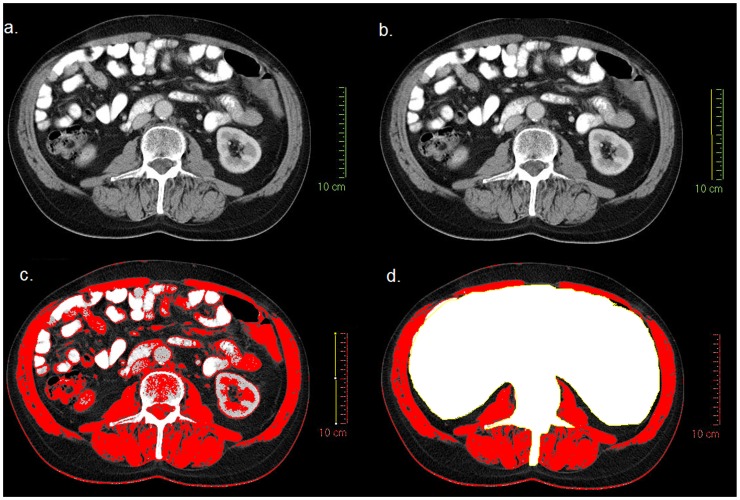
An example of CT image analysis using NIH ImageJ software.(a) the original CT image in JPEG format, (b) the scale is set using a known distance (10 cm) from the original CT image, (c) skeletal muscle thresholds (−29 to+150 HU) are applied, (d) the abdominal contents and L3 vertebrae are cropped and the skeletal muscle cross sectional area calculated in cm2.